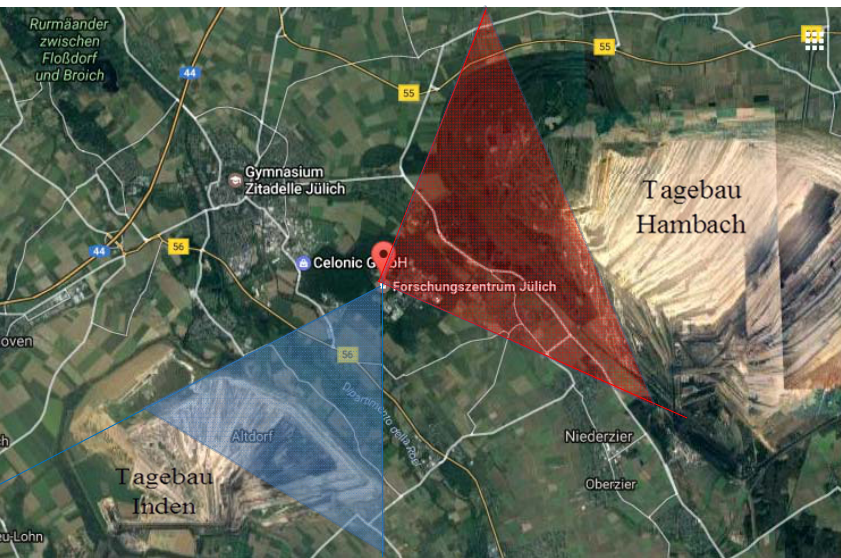
Figure 1. Locations of the Raman lidar system BASIL within the Jülich Research Centre (pink dot). The figure also indicates the location of the Hambach open-pit lignite mine (approximately 3km East of the Research Centre), the large artificial hill Sophienhöhe (both within the angle cone 29–114 ◦ , red shaded area) and a second open-pit lignite mine (approximately 3km south-west of the research centre, within the angle cone 180–240 ◦ , blue shaded